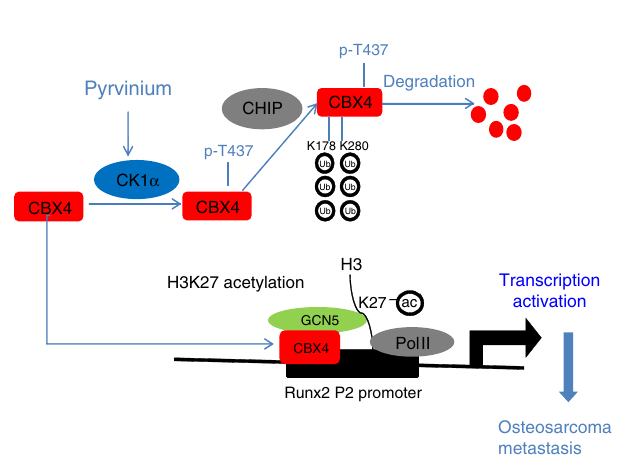
Fig. 8 A proposed model for both function and regulation of CBX4 in osteosarcoma. CBX4 is overexpressed in osteosarcoma and recruits GCN5 to sustain H3K27Ac in the Runx2 promoter to transcriptionally up- regulate Runx2 and then to promote lung metastasis; the phosphorylation of CBX4 at T437 by CK1 α , which is a tumor suppressor in osteosarcoma, facilitates its ubiquitination and degradation by CHIP; PP as a selective activator of CK1 α promotes the degradation of CBX4, which may bene fi t osteosarcoma patients with high expression levels of